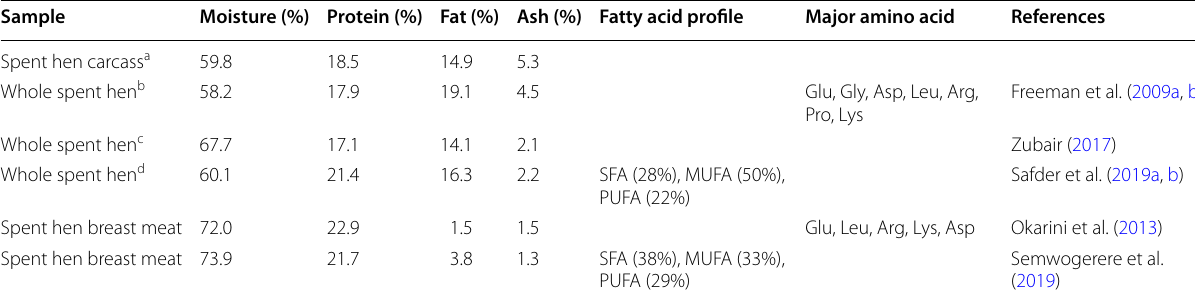
Table 1 Proximate composition, fatty acid and amino acid profiles of raw spent hen and meat Sample